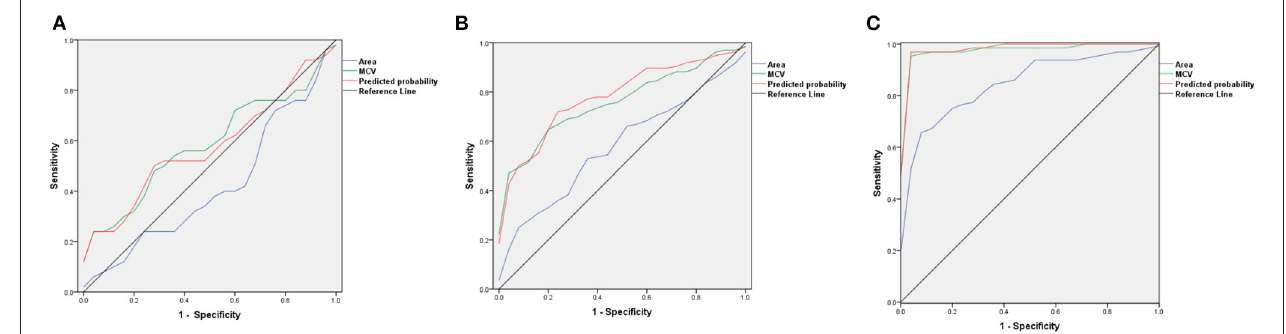
FIGURE 4 | The ROC curves of red blood cells (RBCs) area, mean corpuscular volume (MCV), and predicted probability in patients with AA, MDS, and MA. (A) The ROC curves in patients with AA; (B) The ROC curves in patients with MDS; (C) The ROC curves in patients with MA.